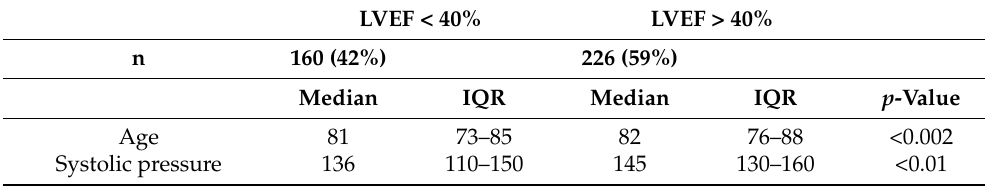
Table 2. Results according to